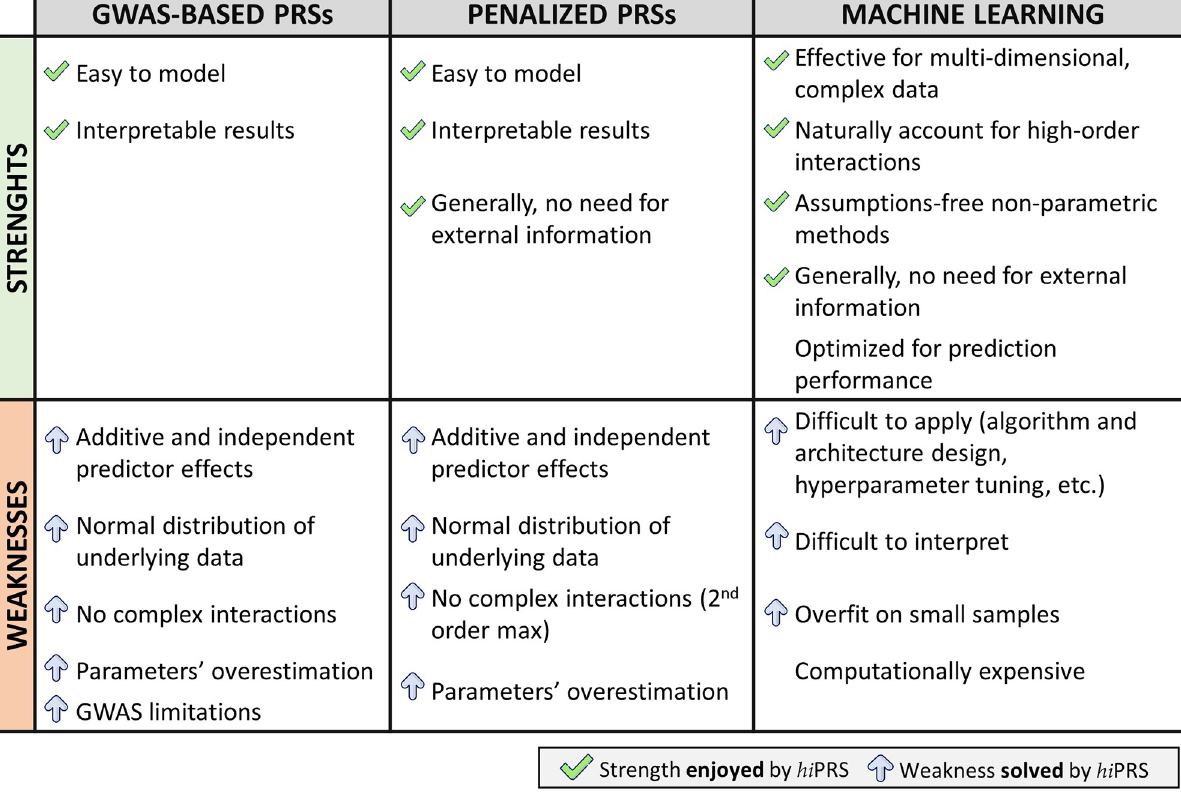
Fig 1. Alternative approaches to polygenic risk scoring vs hi PRS. Strengths (first row) and Weaknesses (second row) of three main categories of PRS methods discussed in the Introduction. The green tick signals that the given point of strength applies to hi PRS as well. The blue arrow signals a point of weaknesses that hi PRS algorithm does not suffer, or some aspect that the algorithm was specifically designed to